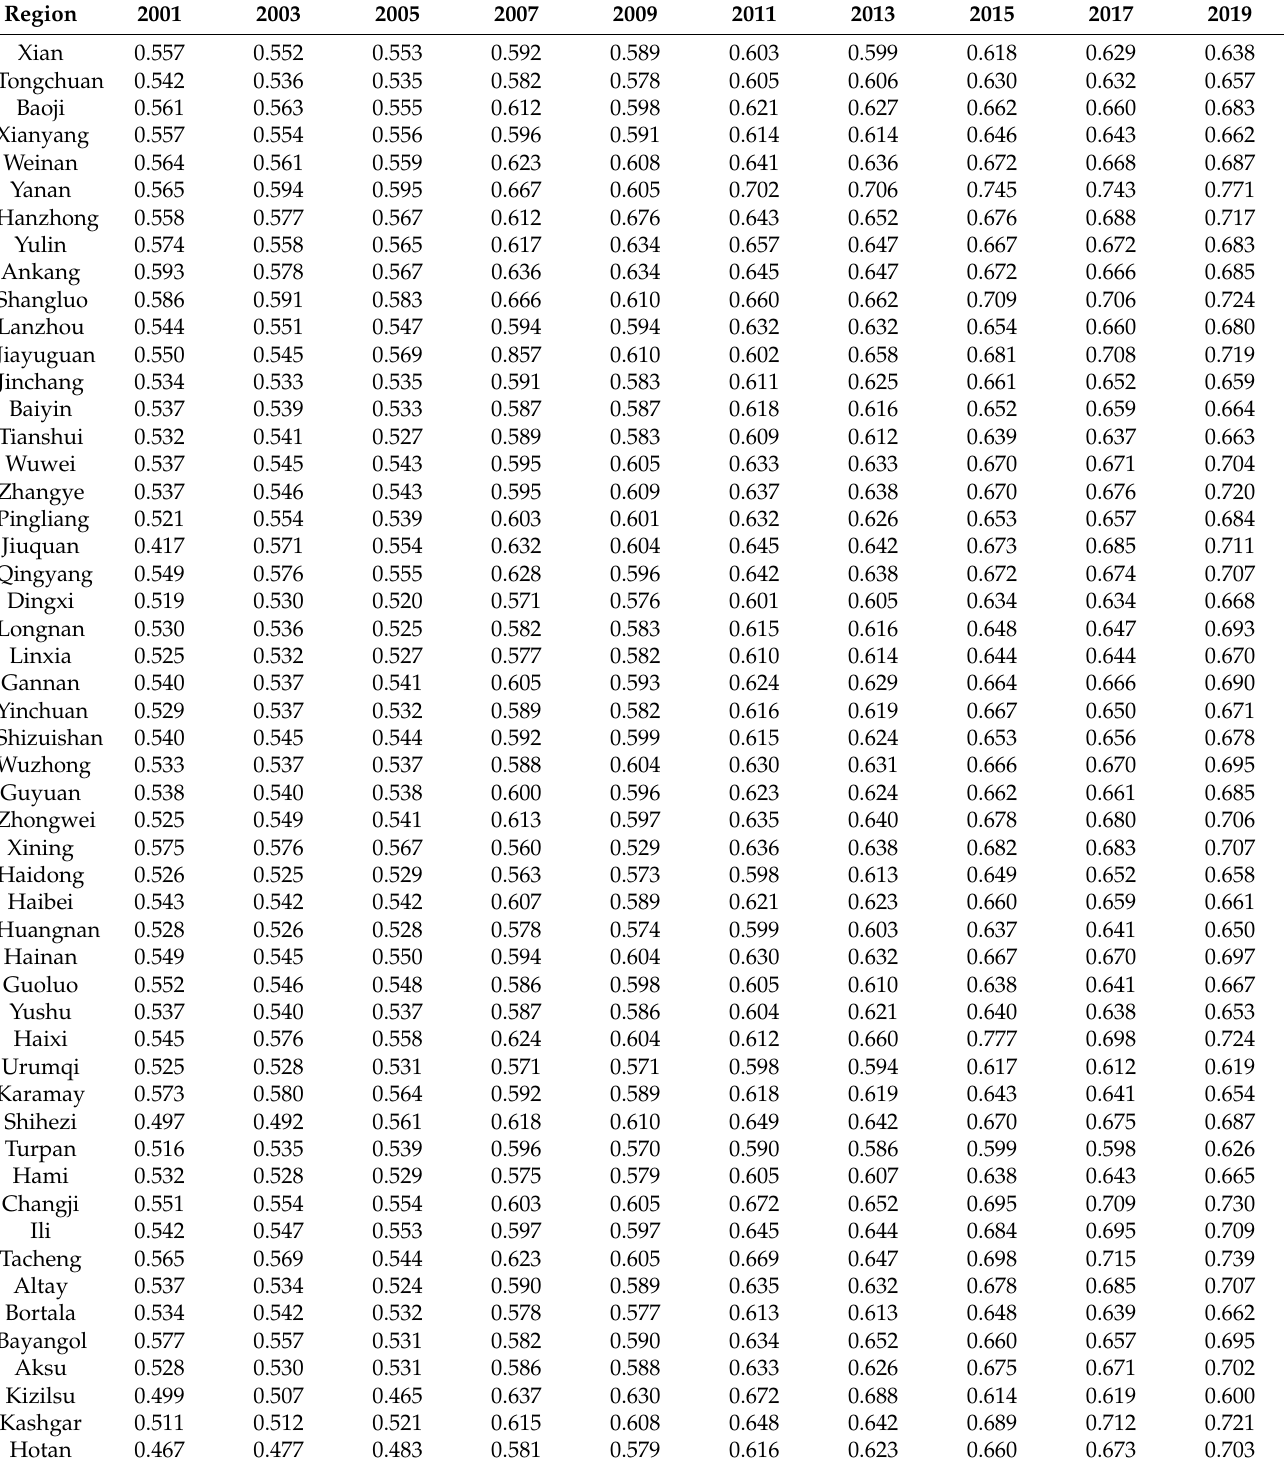
Table 4. Synergy levels of urban and rural water shortage risks from 2001 to